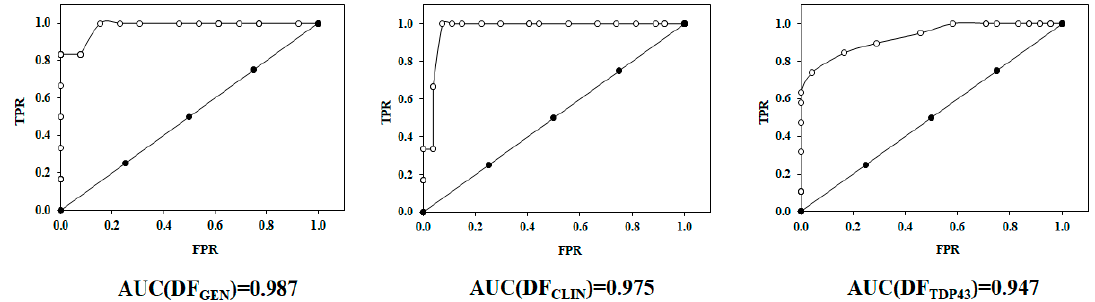
Figure 4. ROC curve for DF GEN., DF CLIN and DF TDP43. TPR: true positive rate; FPR: false positive rate.